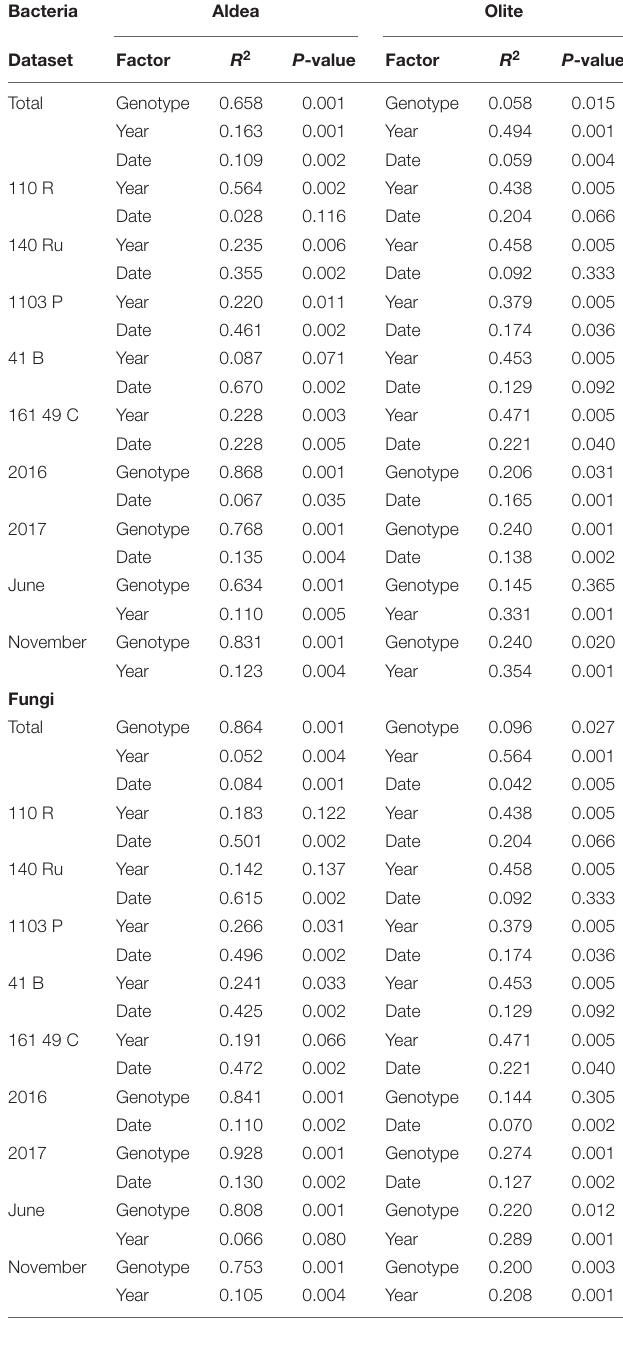
TABLE 2 | Adonis test of category effect on bacterial and fungal Bray–Curtis distance matrix.